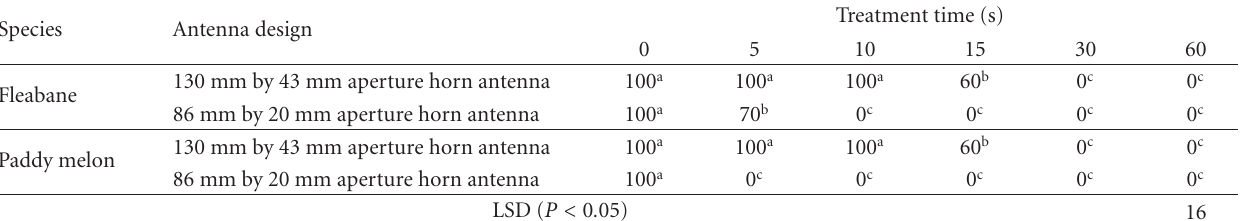
Treatment time (s)